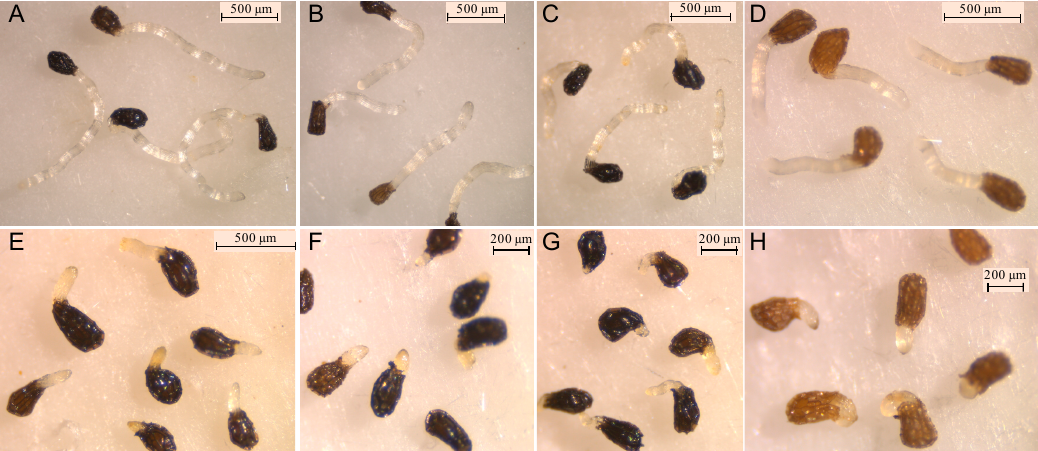
Figure 4. Treatments with control ( A – D ) and compound (4 Z ,8 Z )-matricaria lactone ( 3 ) applied at 0.1mM ( E – H ) on radicles of O. crenata ( A , E ); radicles of O. cumana ( B , F ); radicles of O. minor ( C , G ); and radicles of P. ramosa ( D , H ).